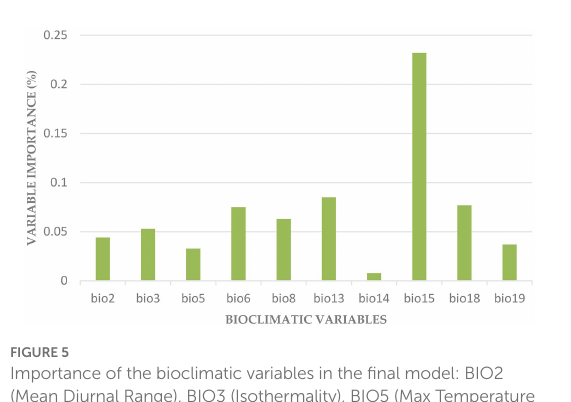
FIGURE 5 Importance of the bioclimatic variables in the final model: BIO2 (Mean Diurnal Range), BIO3 (Isothermality), BIO5 (Max Temperature of Warmest Month), BIO6 (Min Temperature of Coldest Month), BIO8 (Mean Temperature of Wettest Quarter), BIO13 (Precipitation of Wettest Month), BIO14 (Precipitation of Driest Month), BIO15 (Precipitation Seasonality), BIO18 (Precipitation of Warmest Quarter), and BIO19 (Precipitation of Coldest